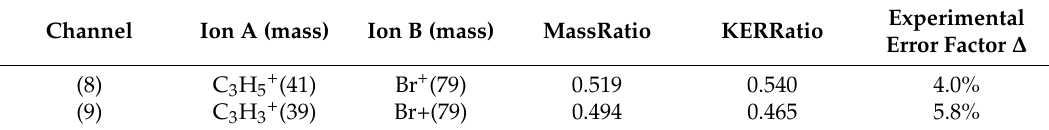
Table 2. The corresponding mass ratio, the calculated KER ratio, and the experimental error ∆ for different CE